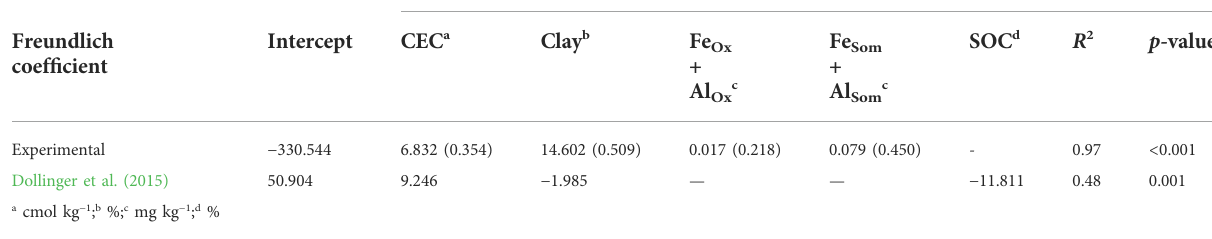
TABLE 9 Multiple linear regression analysis for estimation of Freundlich sorption coef fi cient (K f-mean for experimental and K f for Dollinger) according to soil parameters and Dollinger et al. (2015). Both unstandardized and standardized (in brackets) regression coef fi cients ( p < 0.05) are reported. Regression Coef fi